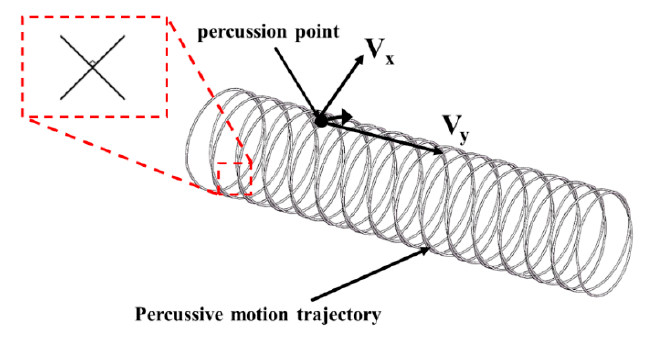
Figure 7. Motion trajectory of percussion point.